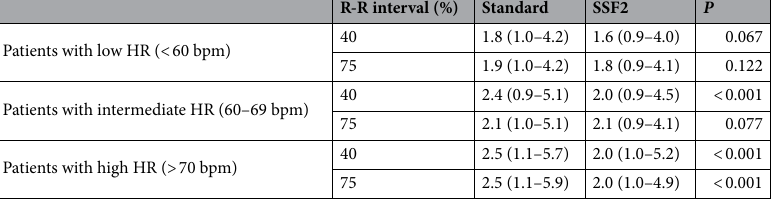
R-R interval (%) Standard